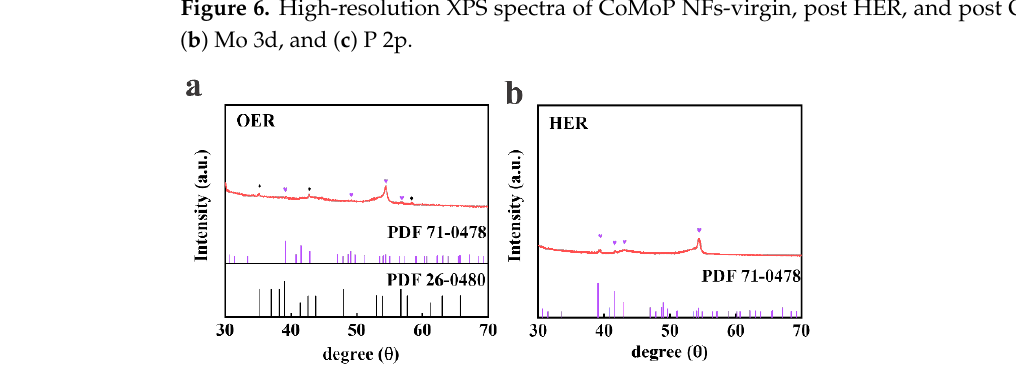
Figure 7. XRD patterns of CoMoP NFs after stability test; ( a ) post OER, and ( b ) post HER.